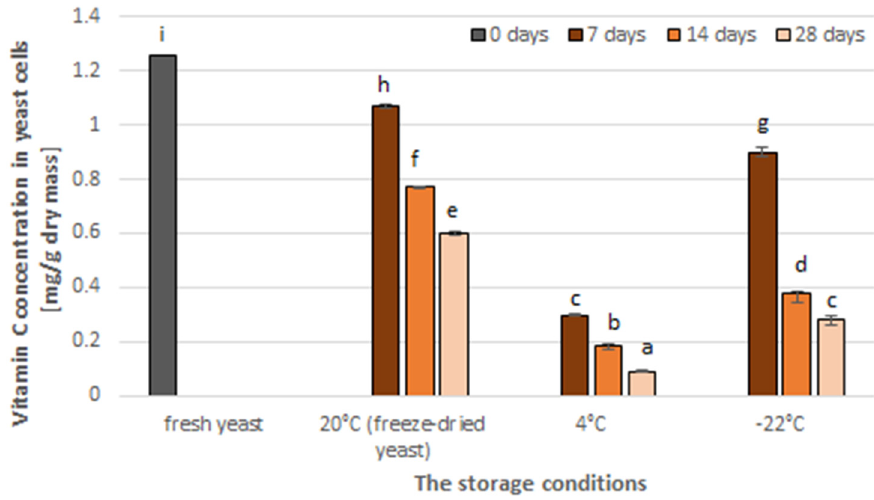
Figure 6. Effect of storage time (0-fresh yeast, 7, 14, 28 days) on vitamin C content in yeast cultures treated with PEF (vitamin C, 5 mg/mL medium; voltage, 1000 V; pulse width, 10 µs; treatment time, 20 min; number of pulses, 1200; after 20 h of cultivation). Each value is the mean ± standard deviation ( n = 3). Bars with the same letter (a–i) are not significantly different ( p < 0.05).